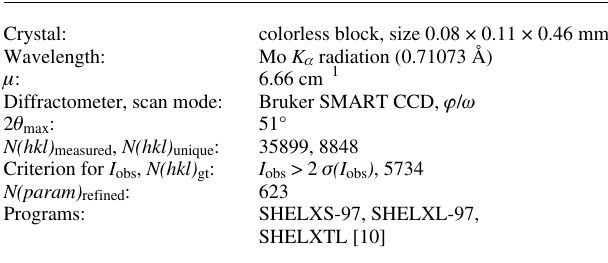
Table 1. Data collection and